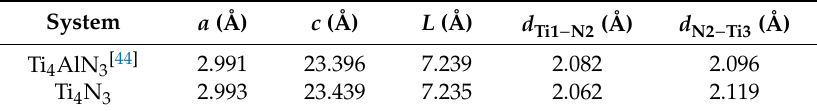
Table 1. Calculated lattice constants a and c , atomic layer thickness L , bond lengths between the N2 atom at subsurface and its neighbor Ti1 atom ( d Ti1-N2 ) or Ti3 atom ( d N2-Ti3 ) at the surface or the next subsurface, respectively.